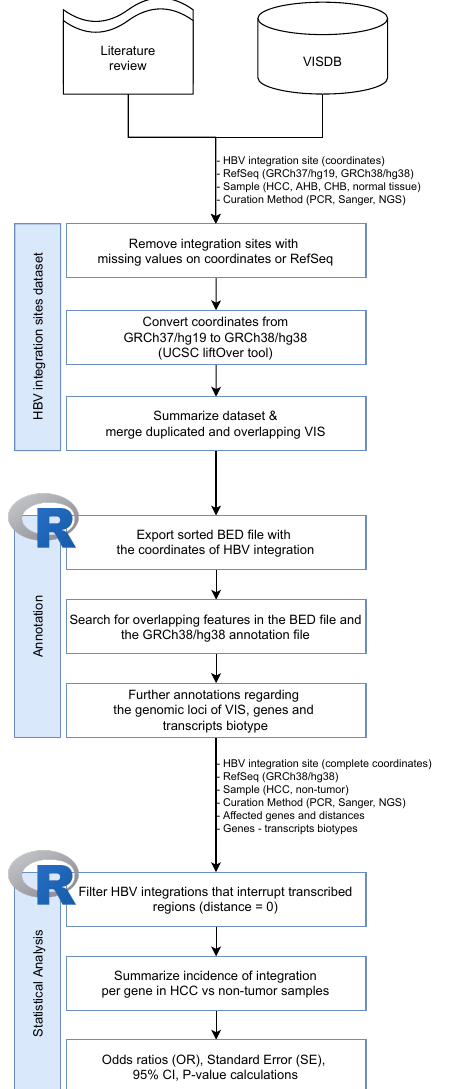
Figure 1. Multi-step workflow diagram of the methodology used to study the effect of HBV DNA in- tegrations in transcribed genomic loci of the human genome (RefSeq GRCh38/hg38). Data regarding HBV DNA integration sites (coordinates) into human samples, the reference sequences used in the initial analysis, and the type of samples (HCC, AHB, CHB, normal tissue) used to export the viral integration sites (VIS), as well as wet-lab methodology information, were mined from 30 research papers and merged with additional metadata that are present in the VISDB database [54]. The dataset was curated: VIS coordinates for which both the start and end positions were absent, or the human reference build was not reported, were removed from the dataset, coordinates that referred to the GRCh37/hg19 human genome reference were converted to GRCh38/hg38 with the UCSC LiftOver tool [55], and duplicated and overlapping VIS were merged. The annotation of the VIS-disrupted genomic loci was performed with in-house developed scripts written in R language by applying a three-step approach that involves the generation of a sorted BED-formatted file with the curated VIS, the identification of overlapping regions between VIS and the GRCh38/hg38 annotation file, and the identification of the corresponding genes and transcripts biotypes. The annotated dataset was filtered in order to include only VIS that disrupt transcriptionally active regions, and the incidence of integrations in HCC and non-HCC samples was summarized per gene. The statistical analysis was based on per-gene calculations of the odds ratios (OR) between HCC and non-HCC samples; the standard error of OR, the 95% CI, and statistical significance was declared at a p -value <